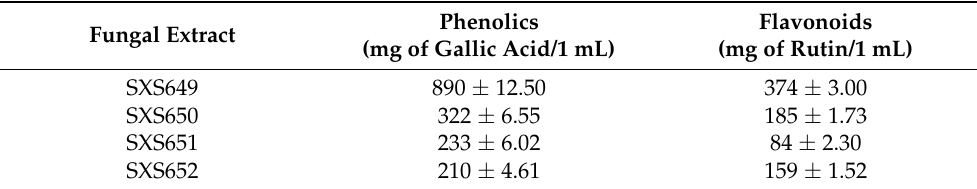
Table 2. Content of total phenolic compounds and flavonoids in 1 mL of extract of the endophytic fungi Colletotrichum sp. SXS649, Pestalotiopsis sp. SXS650, Botryosphaeriales SXS651 and Diaporthe sp. SXS652 isolates from P. rigida Kunth. Values correspond to the mean of the triplicates ± standard deviation.